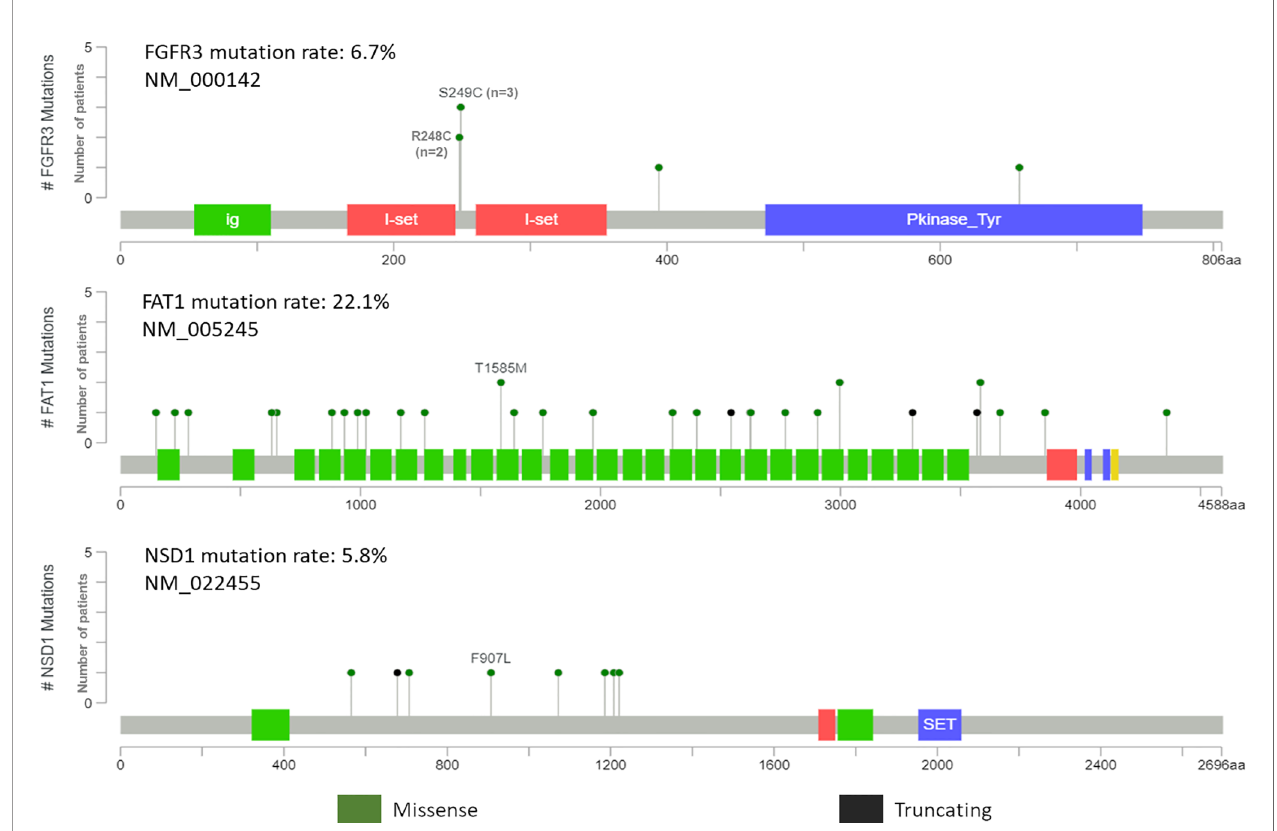
FIGURE 5 | Pictorial representation of single nucleotide variant distribution on domain structure of FGFR3, FAT1 and NSD1